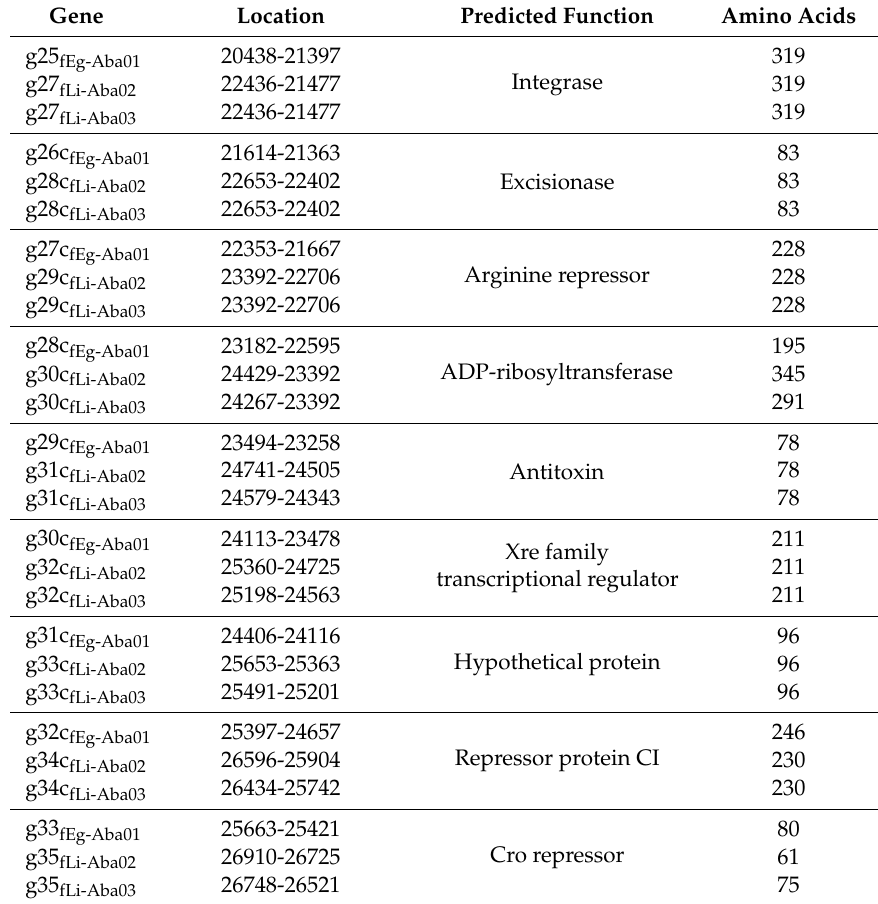
Table 2. The lysogen decision gene cluster in phages fEg-Aba01, fLi-Aba02, and fLi-Aba-03. Gene Location Predicted Function Amino